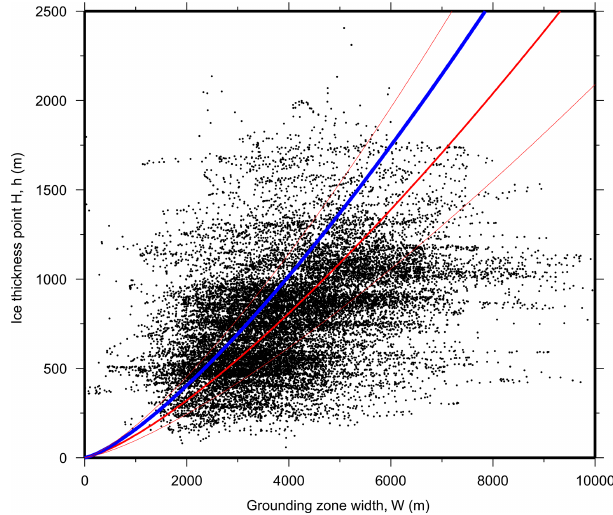
Figure 7. Grounding zone width ( W ) vs. ice thickness at point H ( h ). The solid red line is the fit of equation W = ( 26 . 4 ± 6 )h 3 / 4 to the data, and the dashed red lines are the uncertainty bounds, while the blue line represents the estimation of Vaughan (1995) of W = ( 25 . 4 ± 6 . 2 )h 3 / 4